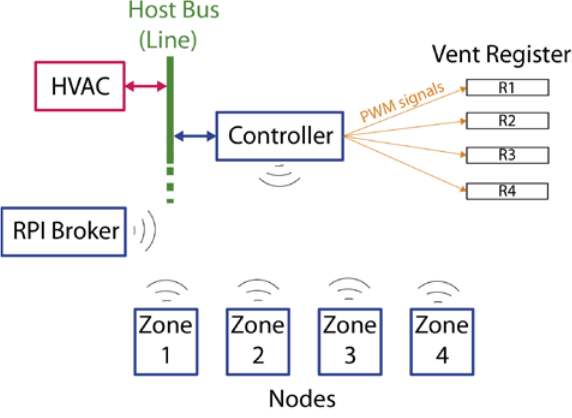
Figure 1. General scheme of the developed system and its elements.